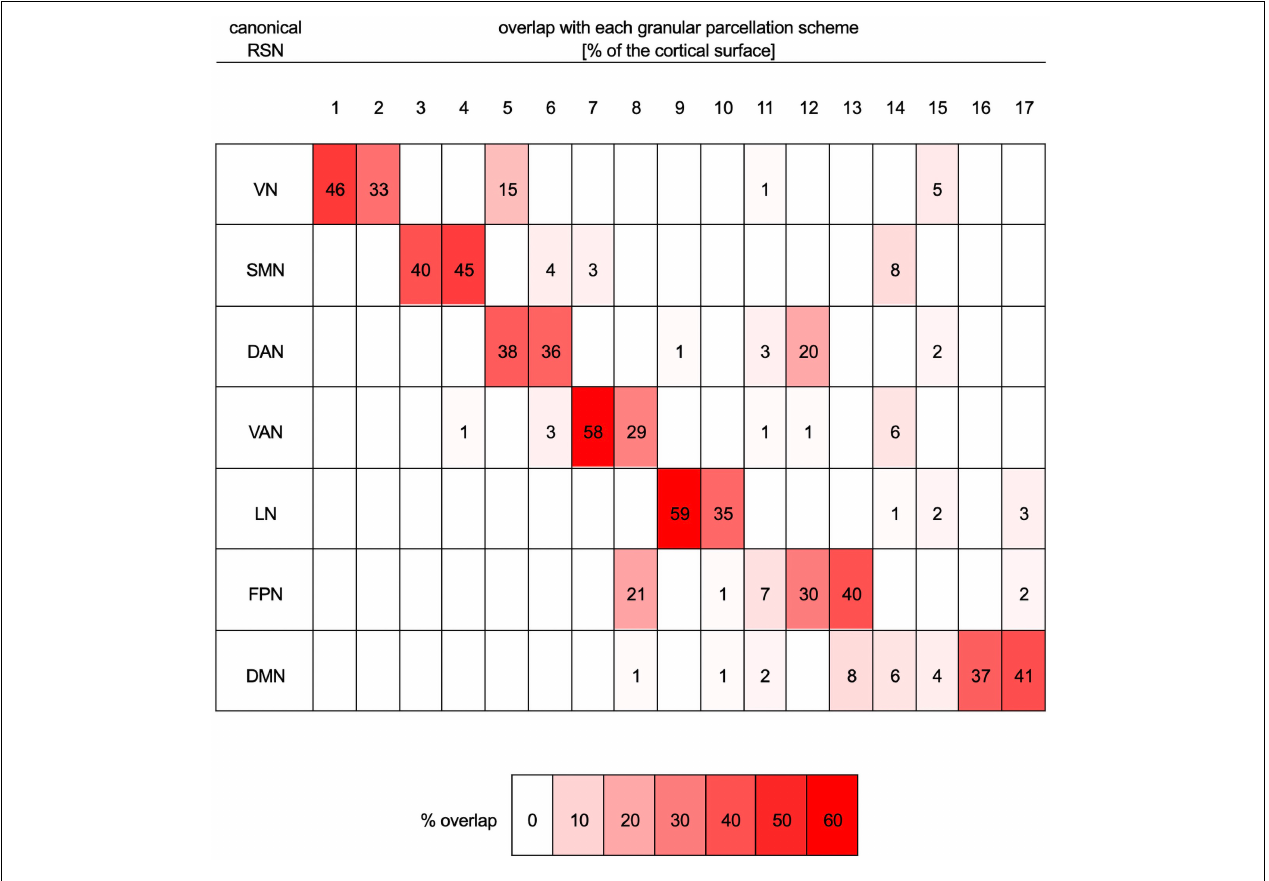
FIGURE 2 | Quantitative mapping of overlaps between the parcellation scheme with seven RSNs onto the more granular parcellation scheme with 17 RSNs. Both schemes are those of Yeo et al. (2011). Each row lists data pertaining to one of the seven canonical networks (VN, SMN, DAN, VAN, LN, FPN, and DMN). Columns list data corresponding to one of the networks ( N 1 to N 17 ) in the more granular 17-network cortical parcellation scheme. For each row (i.e., RSN), the table indicates the percentage of that RSN’s cortical surface area, in the seven-network scheme, that overlaps with each of the more granular networks in the 17-network scheme. For example, 46% of the VN overlaps with N 1 , 33% of it overlaps with N 2 , 15% with N 5 , 1% with N 11 , and 5% with N 15 . For convenience, percentages are also color-coded, where white indicates 0% overlap and bright red indicates maximum overlap (59%). DAN, dorsal attention network; DMN, default mode network; FPN, frontoparietal network; LN, limbic network; RSN, resting state network; SMN, somatomotor network; VAN, ventral attention network; VN, visual